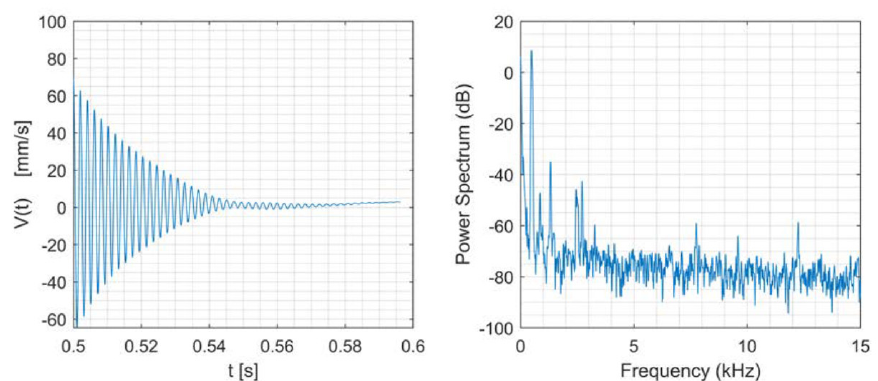
Figure 6. Example of a signal restricted to free decay range.